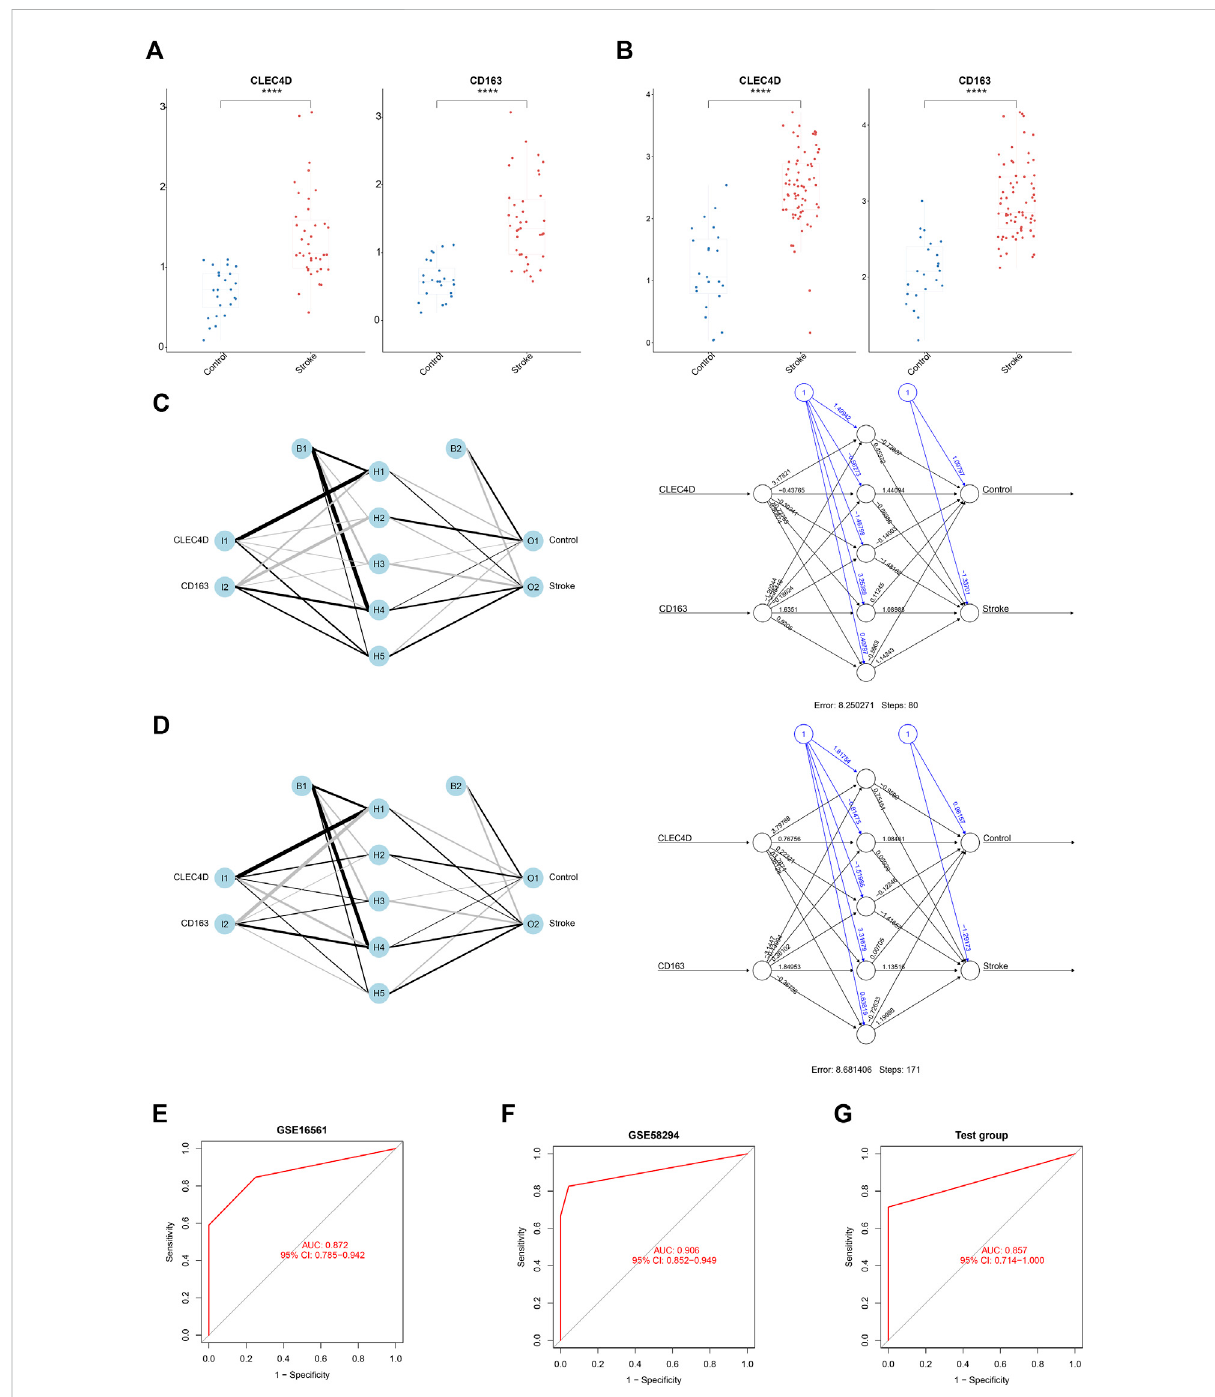
FIGURE 5 The Diagnostic Value of Three Key Immune-Related Biomarkers in IS. (A,B) Box plot analysis showing the expression values of IS immune- relatedbiomarkersinISpatientsvscontrols.(The p -valuewasobtainedfromthe t -test.**** p < 0.0001.) (C) NeuralNetworkmodelconstructedusing GSE16561. (D) Neural Network model constructed using GSE58294. (E) ROC curves of the Neural Network diagnostic model constructed using GSE16561. (F) ROCcurvesoftheNeuralNetworkdiagnosticmodelconstructedusingGSE58294. (G) ValidationoftheNeuralNetworkmodelin the GSE102541